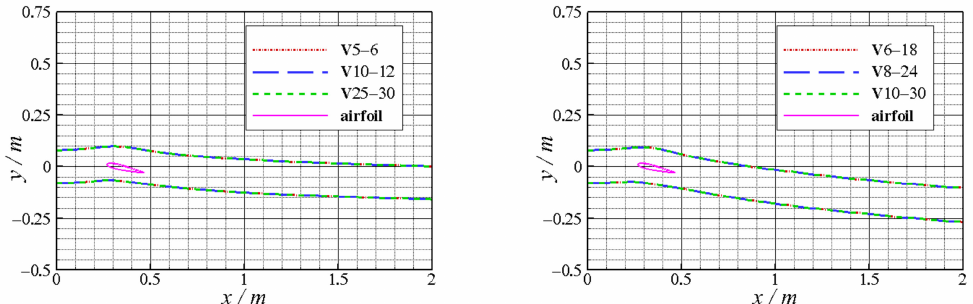
Figure 21. Comparisons of the jet deflection with different velocity ratios at α = 12 o .